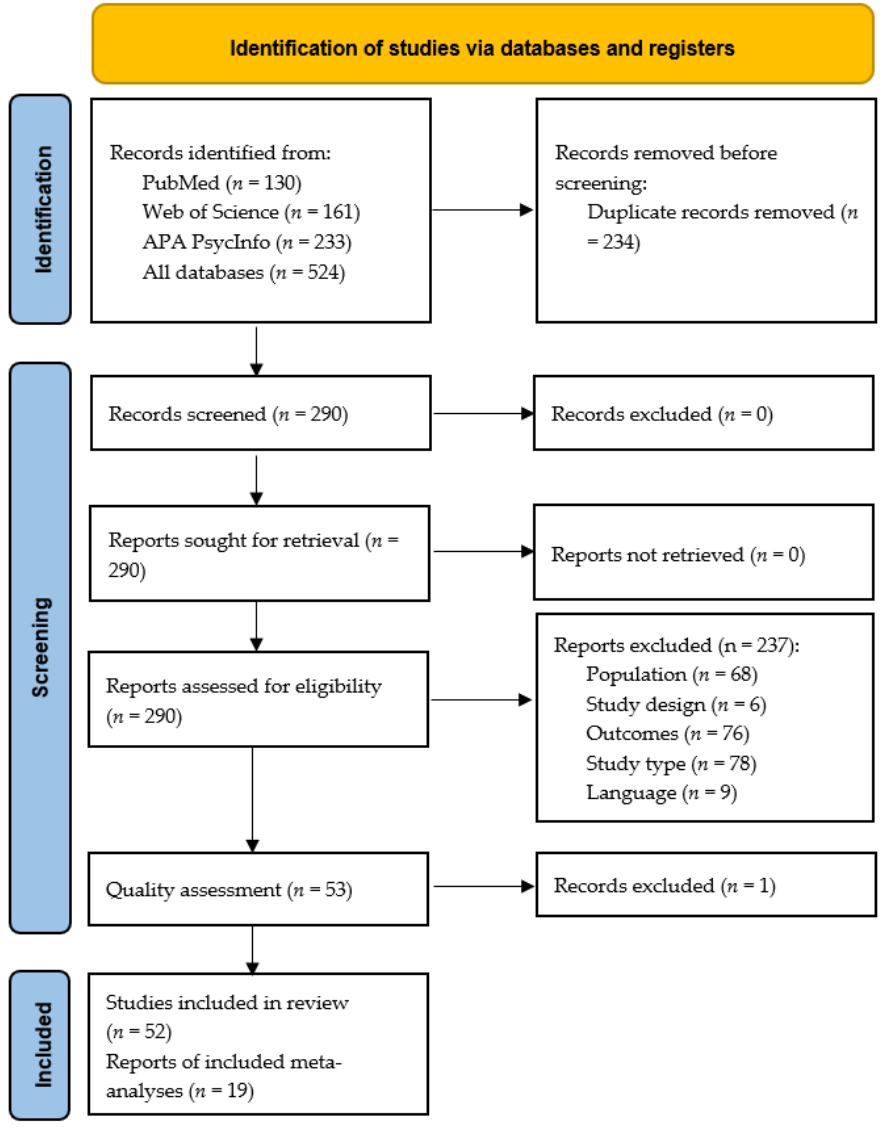
Figure 1. PRISMA flow diagram illustrating the process of our review, screening, and article selec- tion processes.